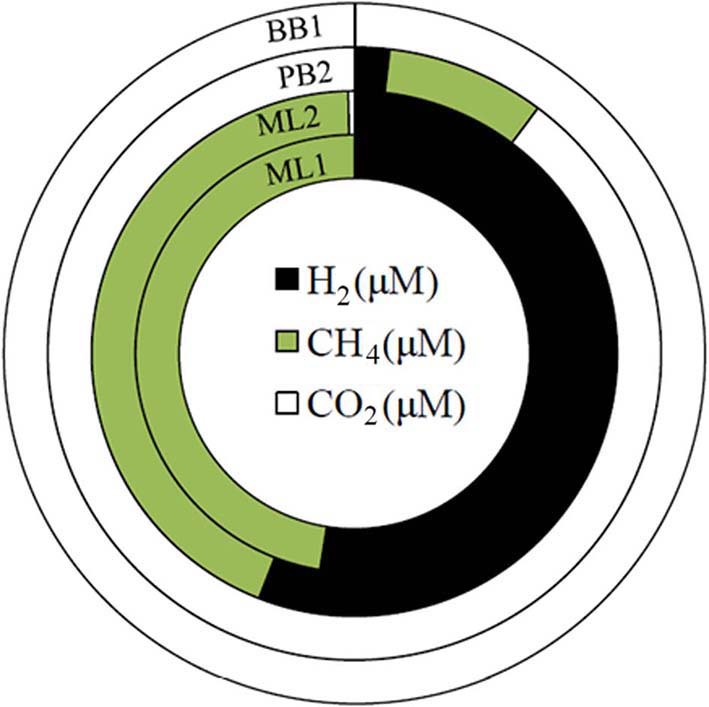
Dissolved gas findings (reported in Table 3) shown as side-by-side gas doughnut diagrams. Note that the sampled sites range from H2- and CH4-dominated (ML1 and ML2, inner green and black doughnuts) to nearly completely CO2-dominated (BB1, white doughnut).